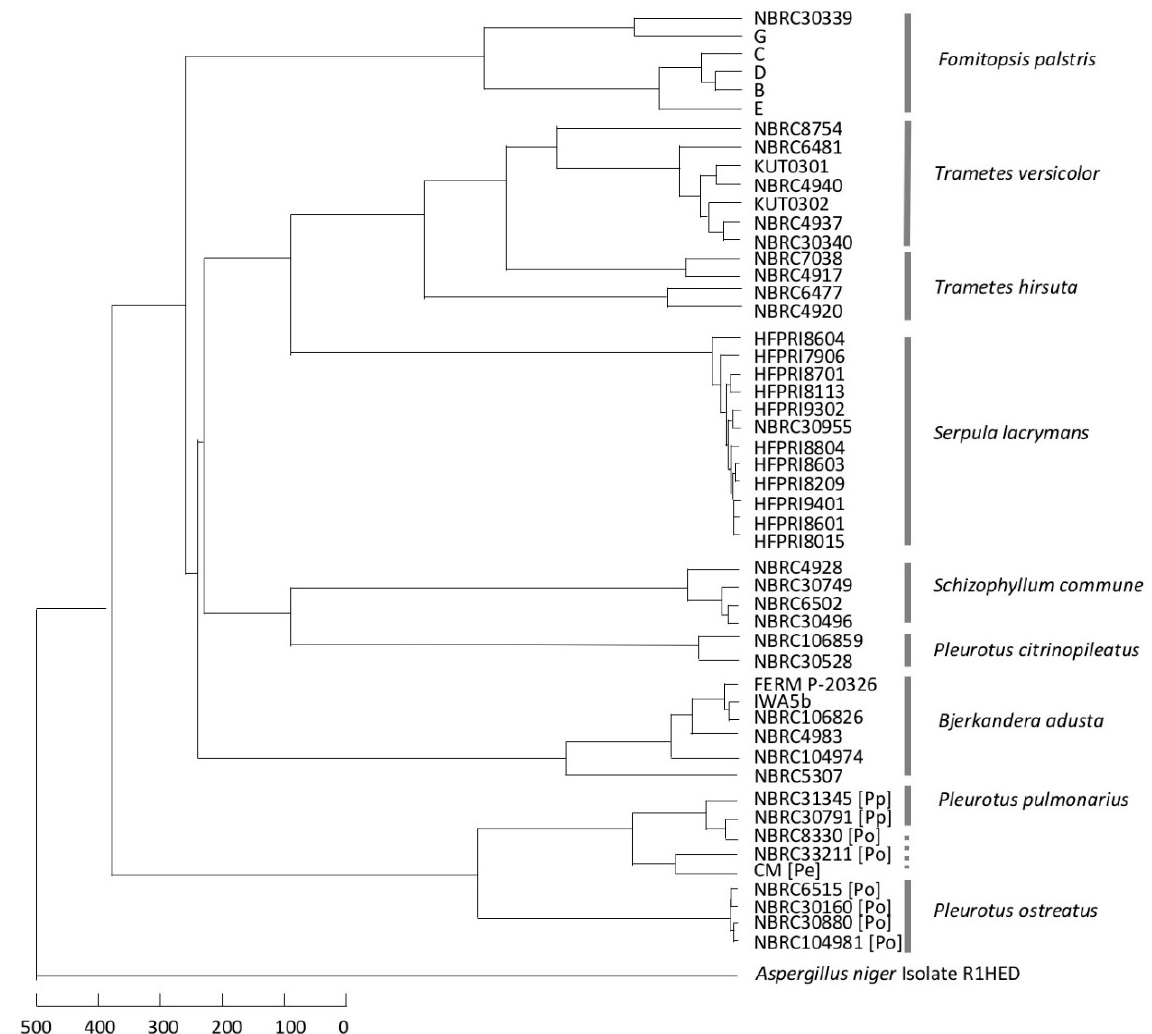
Figure 2. Mass spectral pattern (MSP) dendrogram of extracted whole-cell proteins from wood- rotting fungi. Pp: P. citrinopileatus ; Po: P. ostreatus ; Pe: P. eryngii ; Pc: P. citrinopileatus ; Th: T. hirsuta ; Tv: T. versicolor . Mass spectrum information of Aspergillus niger in the Biotyper version 3.0 database was employed as an outgroup. The dendrogram was created using Biotyper and distance units correspond with the relative similarity of MSPs.